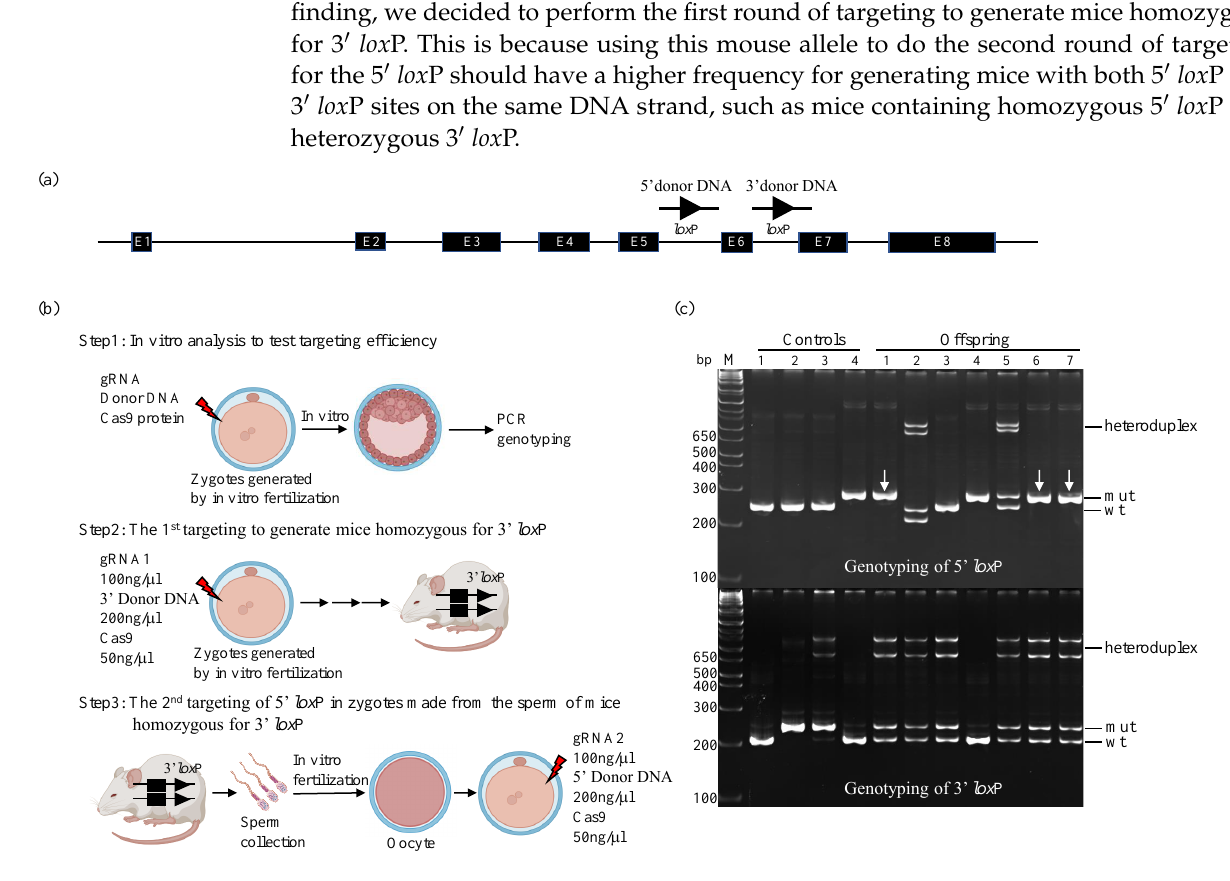
Figure 1. Generation of the Prune1 conditional allele by CRISPR/Cas9-based gene-targeting. ( a ) Genomic structure of the mouse Prune1 locus. The regions used for inserting two lox P sites that flank exon 6 (E6) are shown. ( b ) Schematic representation of a targeting procedure that allowed to efficiently generate the Prune1 conditional alleles within five months. It consists of three steps: